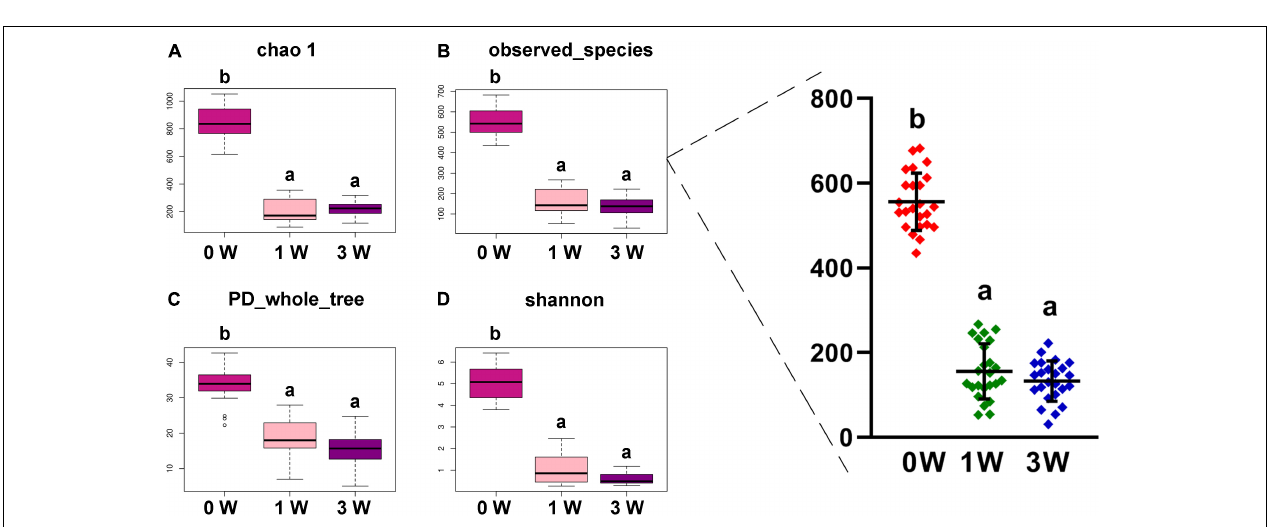
FIGURE 2 | The α diversity of fecal microbiota. (A) Chao 1. (B) Observed species. (C) PD whole tree. (D) Shannon. Data represented as mean ± SD ( n = 24). Bars with different letters differ significantly ( P < 0.05). Chao1, observed species, and PD whole tree are species richness indices, and the Shannon index reflects the diversity of gut microbiota. PD, phylogenetic